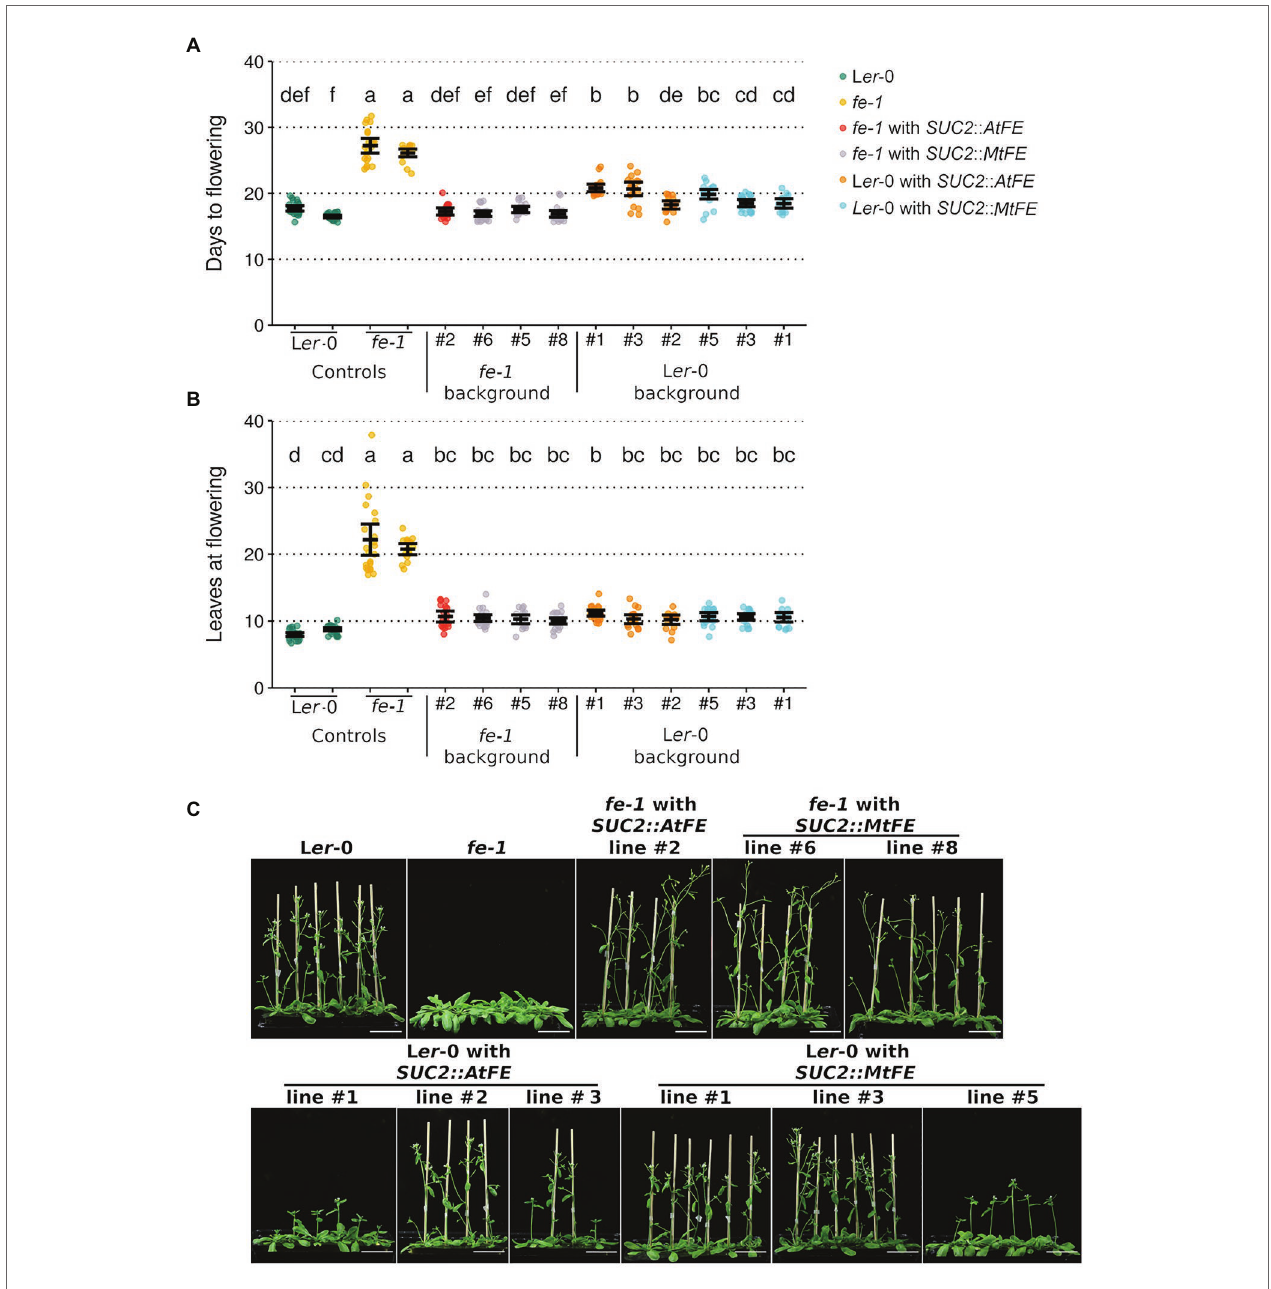
FIGURE 2 | MtFE complements the A. thaliana fe-1 mutant. (A) and (B) plot the flowering time of T 3 SUC2::MtFE and SUC2::AtFE/APL plants in both the fe-1 and L er -0 backgrounds. Flowering time was measured in (A) days and (B) total leaves at the time of flowering. Individual plants ( n = 15–24) are plotted as points and black bars depict the mean bounded by 95% confidence intervals. Different letters indicate significantly different results via a one-way ANOVA (type III sums of squares; α = 0.05). (C) presents representative photographs of 27 days old plants. The white scale bar represents 5